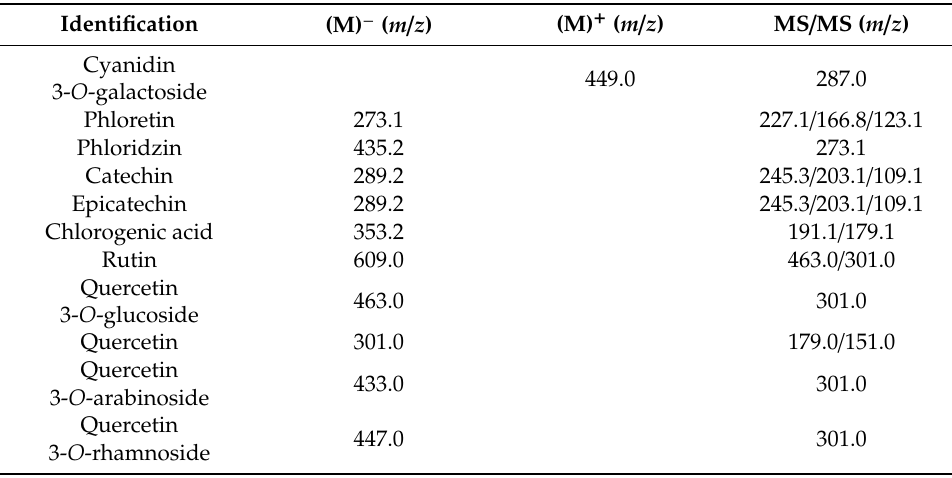
Table 1. MS data of phenolic compounds from